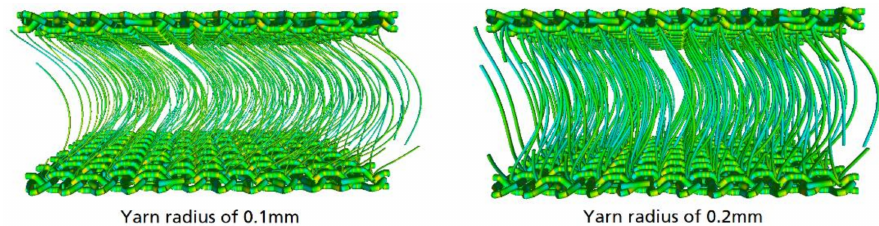
Figure 17. Simulation of the fluid-solid interaction with the same in- and out-flow conditions, same initial conditions but different yarn thicknesses. Fixated bottom and top. The yarn deflection and axial stresses in yarns are